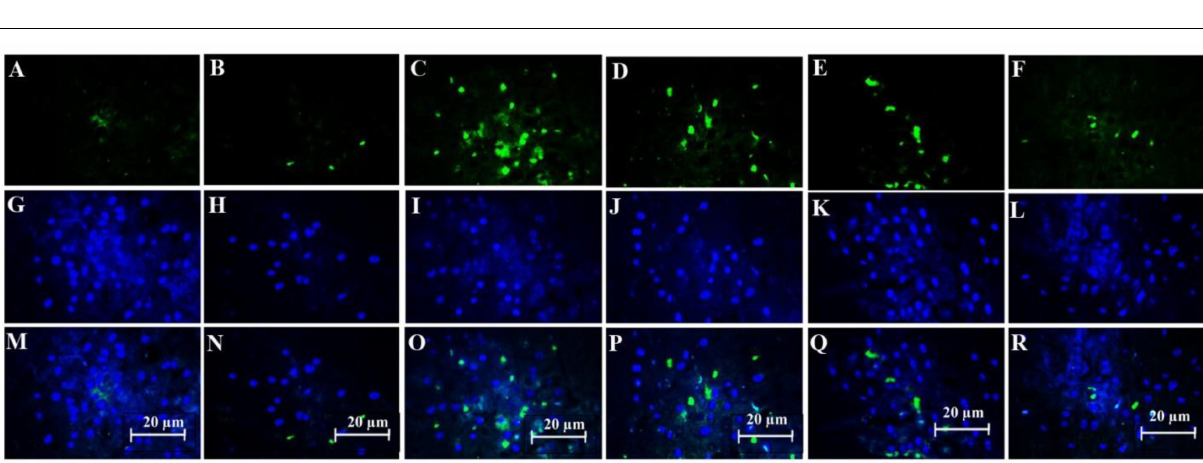
Frontiers in Behavioral Neuroscience |